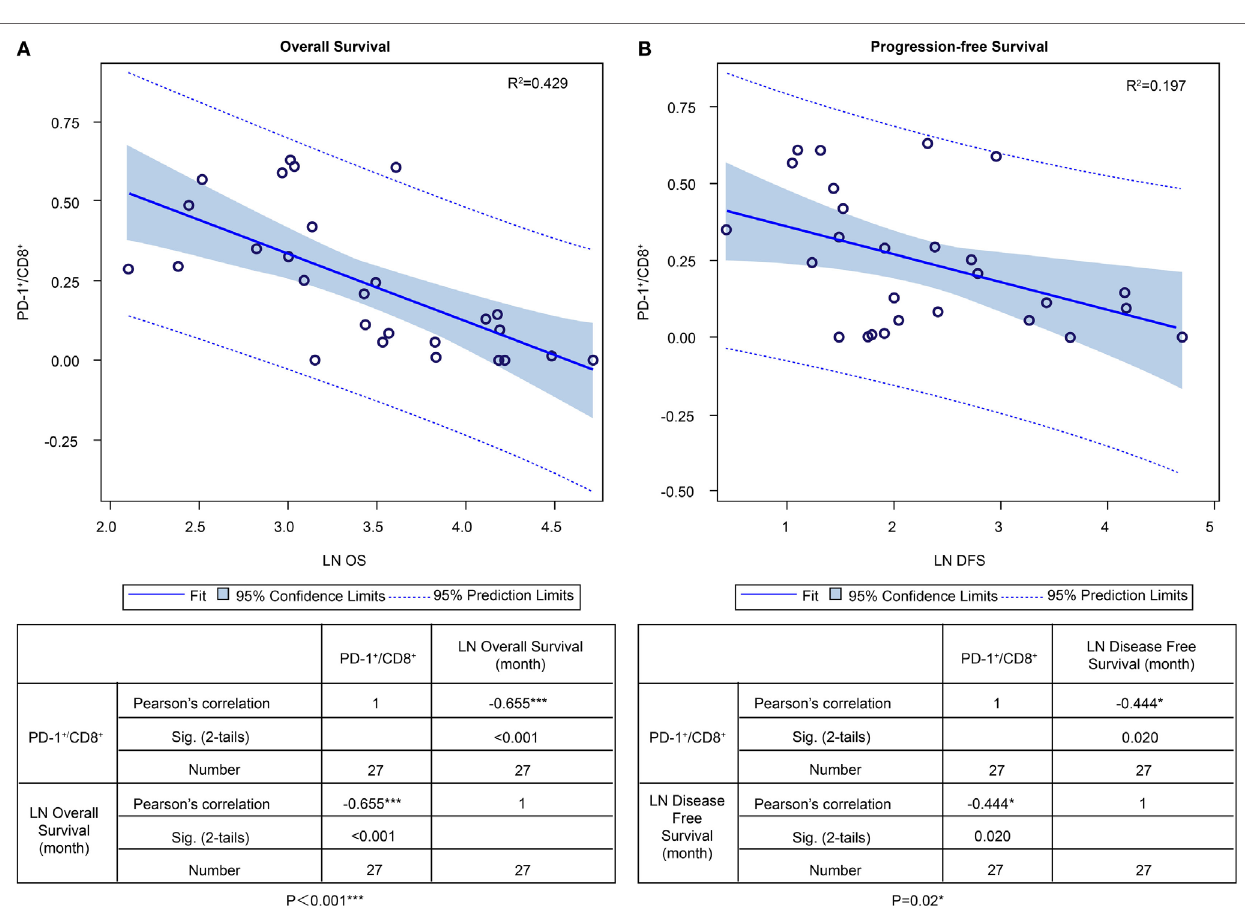
FigUre 6 | PD-1 + /CD8 + ratios of individual patients’ tumor-infiltrating lymphocytes and overall survival (OS) and progression-free survival (PFS) in the ADCTA group. Pearson’s correlation of each patient’s PD1 + /CD8 + ratio value and their OS (a) and PFS time (B) after natural logarithm transformation.